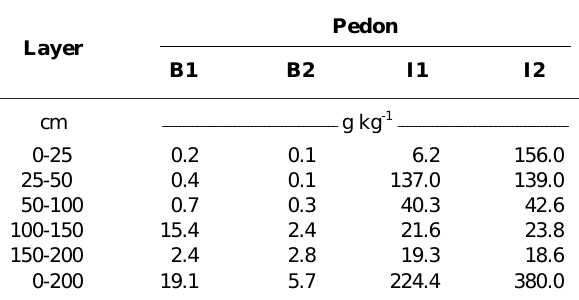
concentrations in d